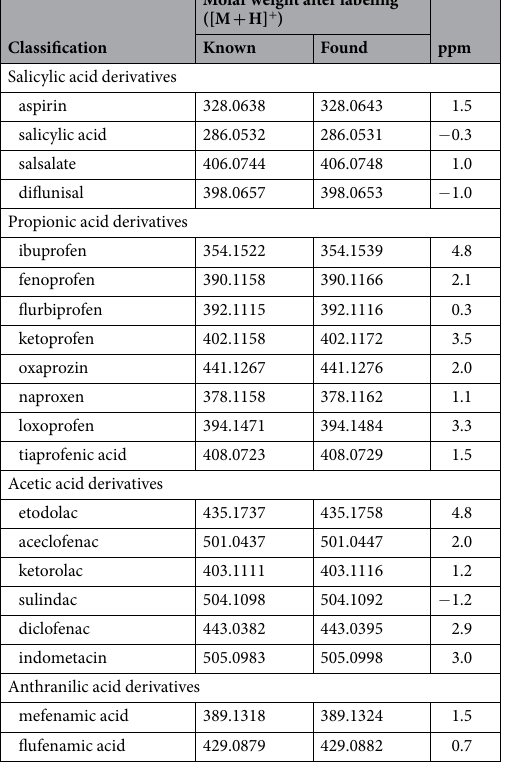
Table 2. NSAID derivatives confirmed by